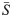
Mushroom body output neuron degree distributions in larval D. melanogaster.(a) Number of inputs to MBONs. Shaded histograms: empirical distribution. Black curve: the marginal simplex area distribution at the maximum likelihood value of α, after integrating out the number of synapses S¯ against its empirical distribution. Blue curve: the maximum likelihood binomial distribution. (b) Lower bound for the log evidence ratio (log odds) for the fixed net weight and binomial wiring models. Positive numbers favor the fixed weight model. Evidences computed by a Laplace approximation of the marginalization over the parameters. (c) Likelihood vs model parameter for the fixed net weight (black) and binomial (blue) models).